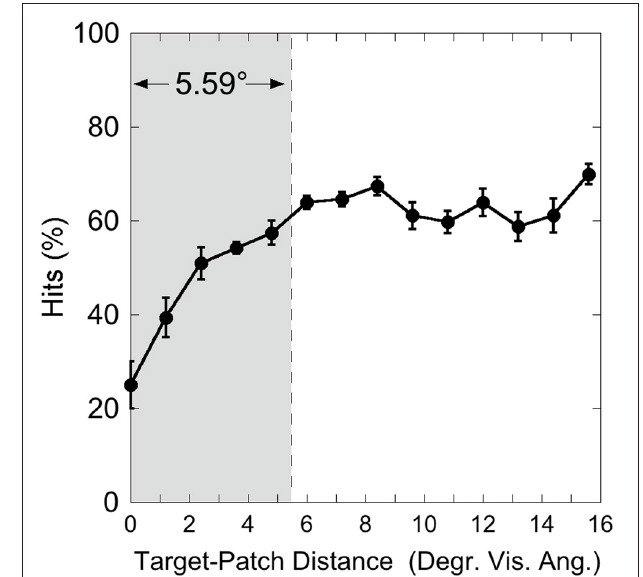
FIGURE 2 | Experiment 1: hits and false alarms averaged over color conditions as a function of patch position. Solid line and filled circles show hits on the target at − 3 . 5 ◦ , dotted line and unfilled circles show hits on the target at + 3 . 5 ◦ . The columns on the bottom depict false alarms as a function of patch position. Black bars depict standard errors.